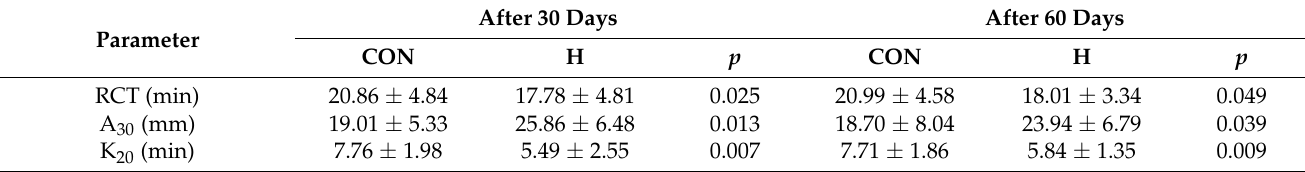
Table 3. Effect of the addition of oxyhumolite to the diet on milk coagulation parameters (Mean ± SD). After 30 Days After 60 Days Parameter CON H p CON H p RCT (min) 20.86 ± 4.84 A 30 (mm) 19.01 ±